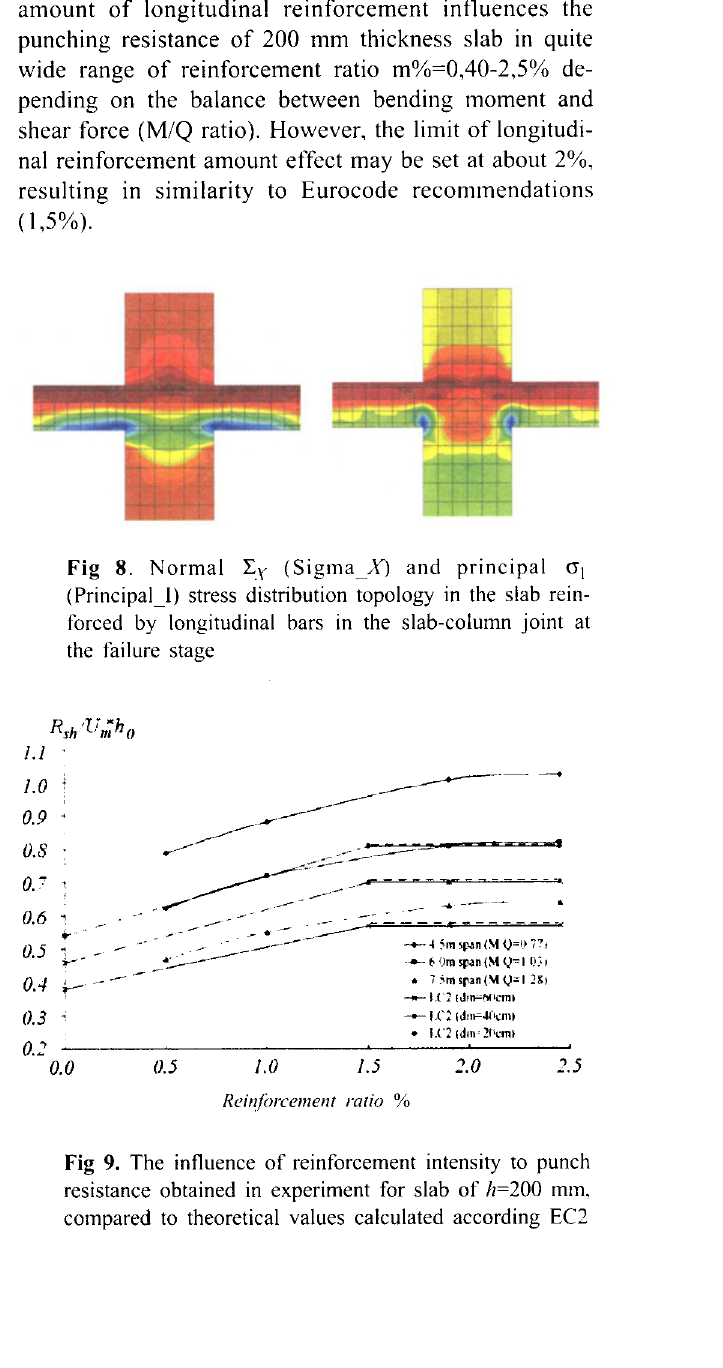
Fig 9. The influence of reinforcement intensity to punch resistance obtained in experiment for slab of h=200 mm. compared to theoretical values calculated according